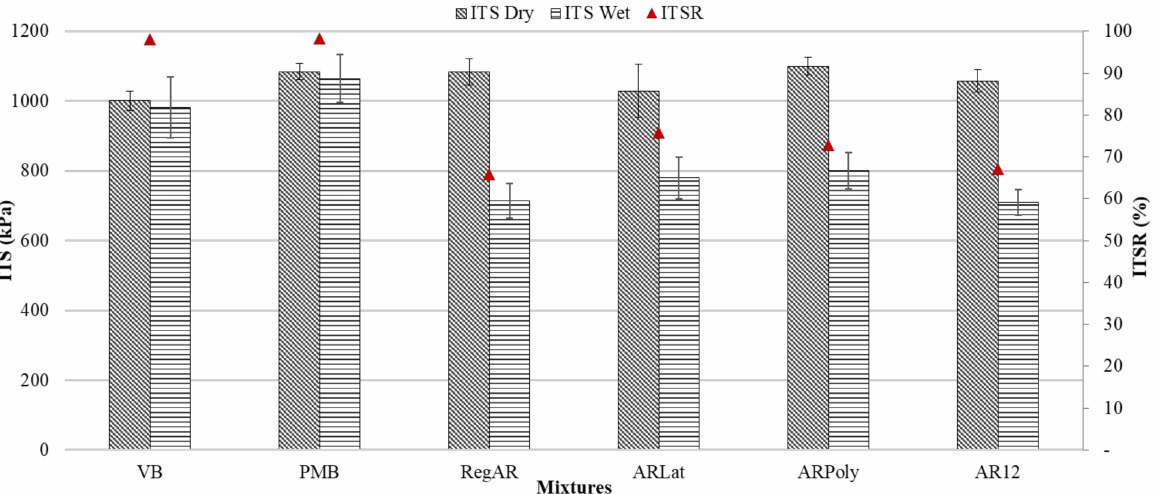
Figure 5. Average values of indirect tensile strength, error bars indicate the standard deviation about the